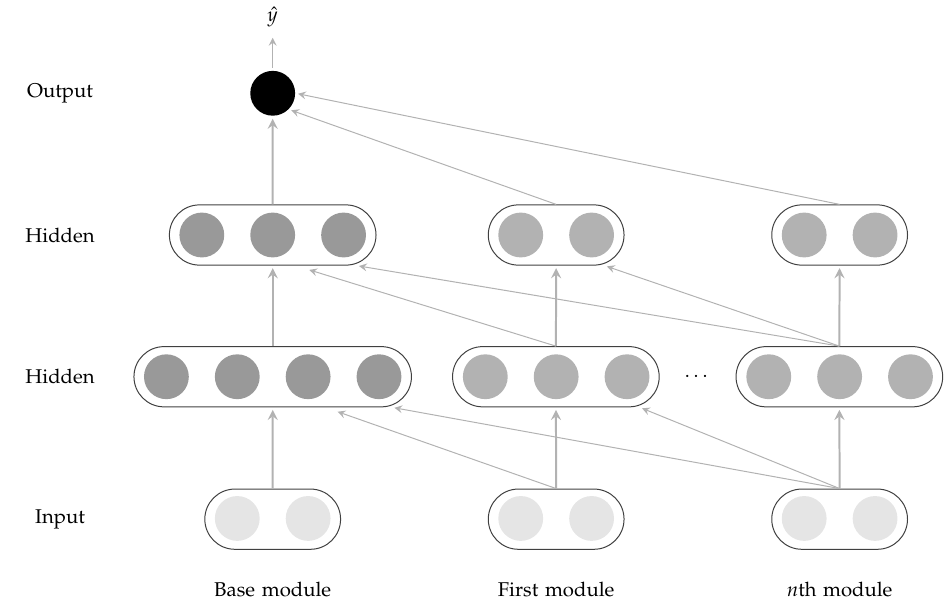
Figure 4. Nested adaptive neural network, as idealized by Ghaboussi and Sidarta